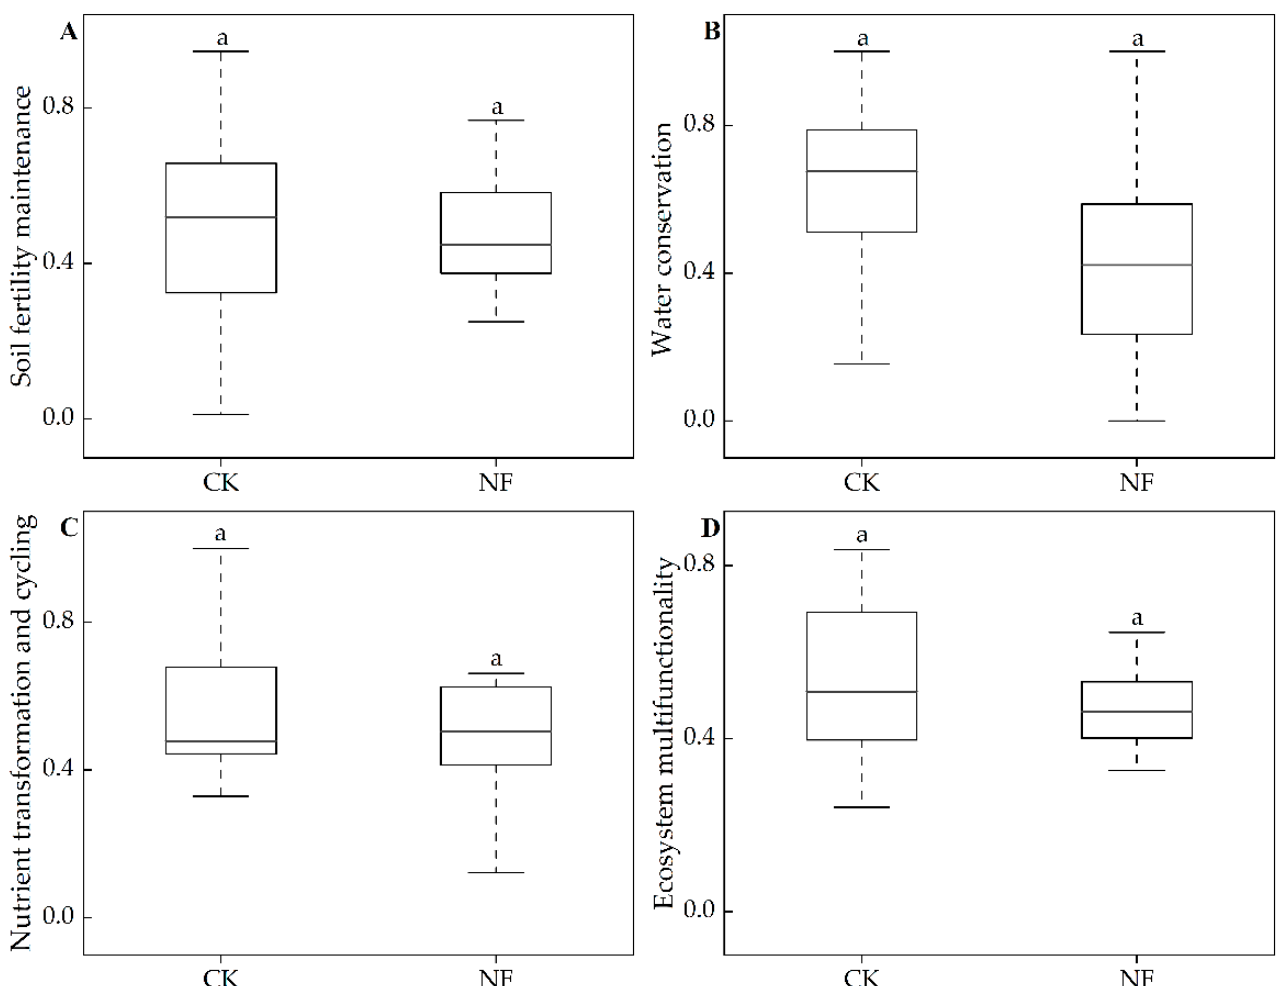
Figure 3. Effects of main land-use types on ecosystem functions. ( A ), soil fertility maintenance; ( B ), water conservation; ( C ), nutrient transformation and cycling; ( D ), ecosystem multifunctionality. a: Same lowercase letters represent nonsignificant differences between NF and CK ( p > 0.05).